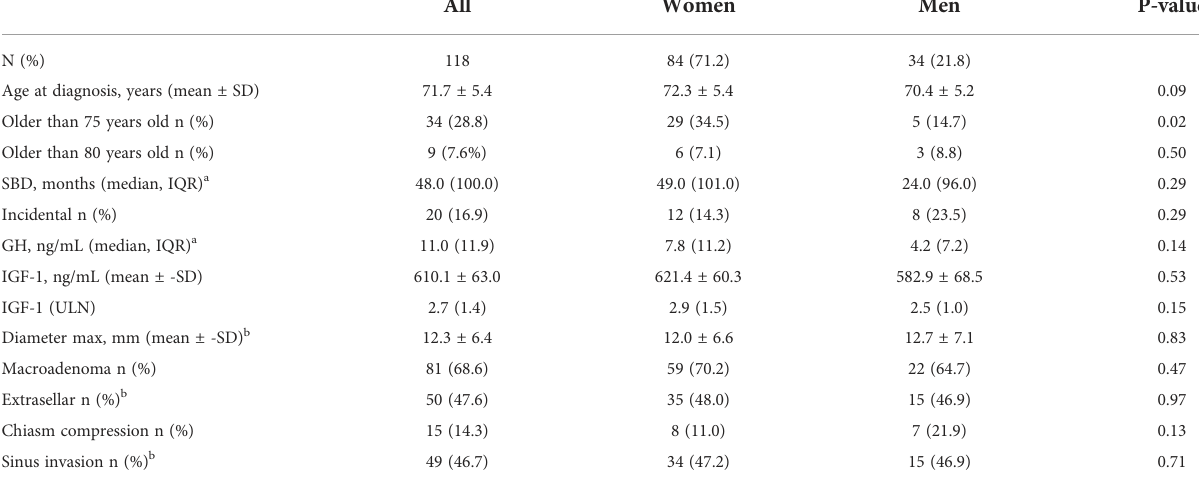
TABLE 1 Baseline characteristics at diagnosis of